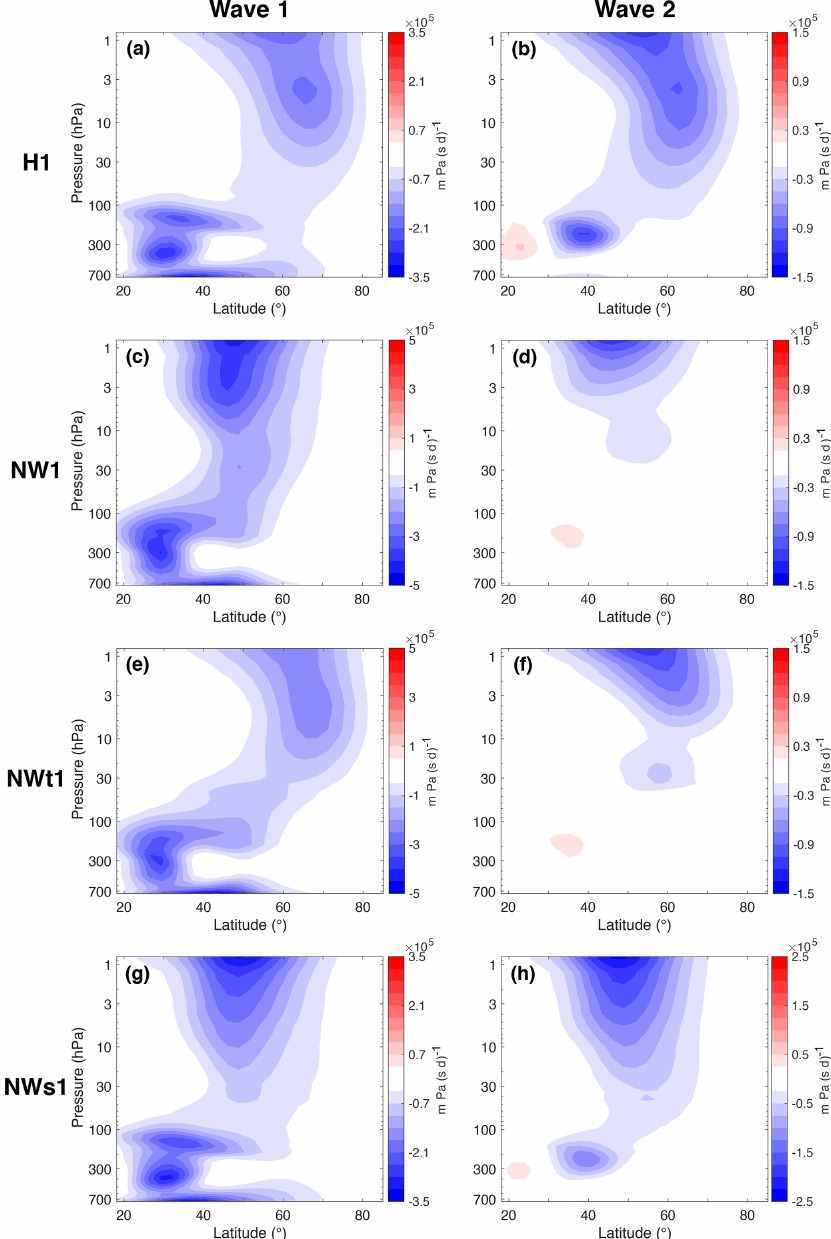
Figure 5. Vertical component of EP flux ( F p ) for H1 (a, b) , NW1 (c, d) , NWt1 (e, f) and NWs1 (g, h) . (a, c, e, g) Wave 1 components. (b, d, f, h) Wave 2 components. Values are scaled by p 0 /p , where p 0 = 1000hPa. Contour intervals are 35 (a, g) , 15 (b, d, f) , 50 (c, e) and 25 (h) (in kmPa ( sd ) − 1